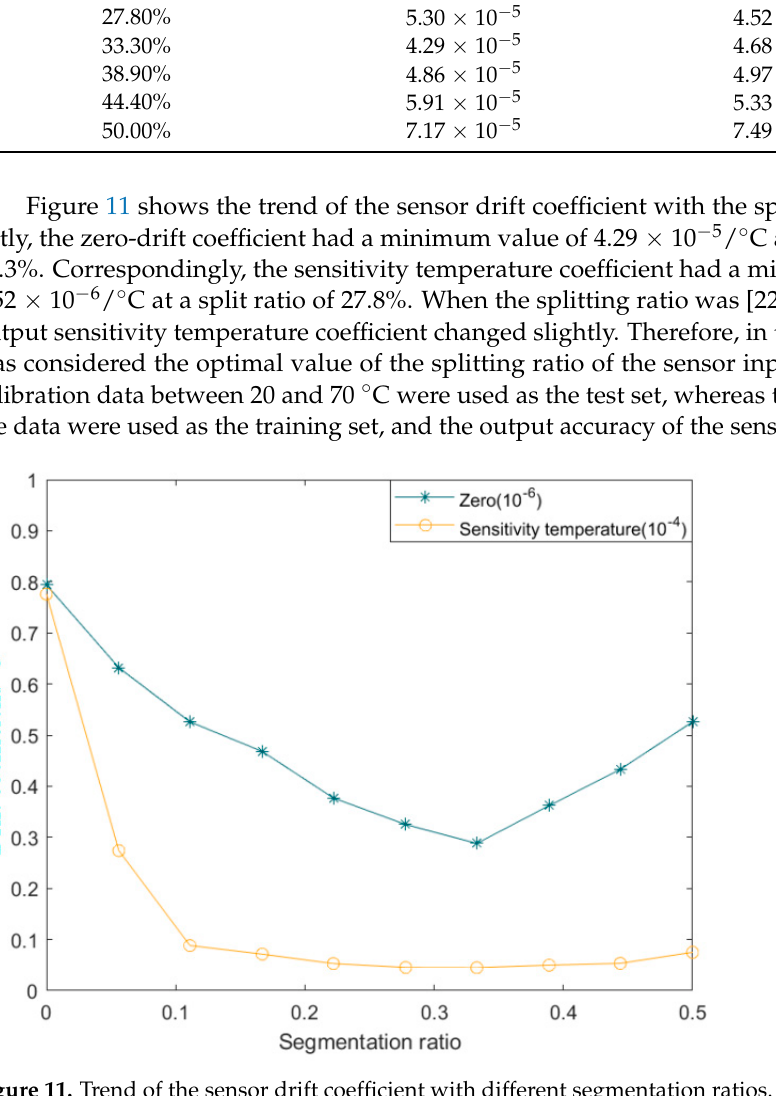
Figure 11. Trend of the sensor drift coefficient with different segmentation ratios.